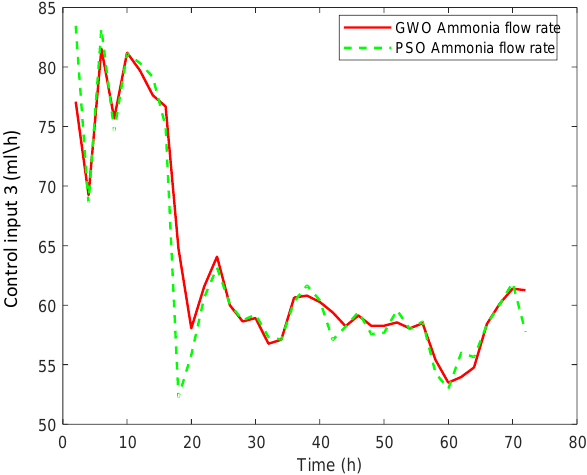
Figure 10. GWO-NMPC controlled ammonia flow rate u 3 with optimal